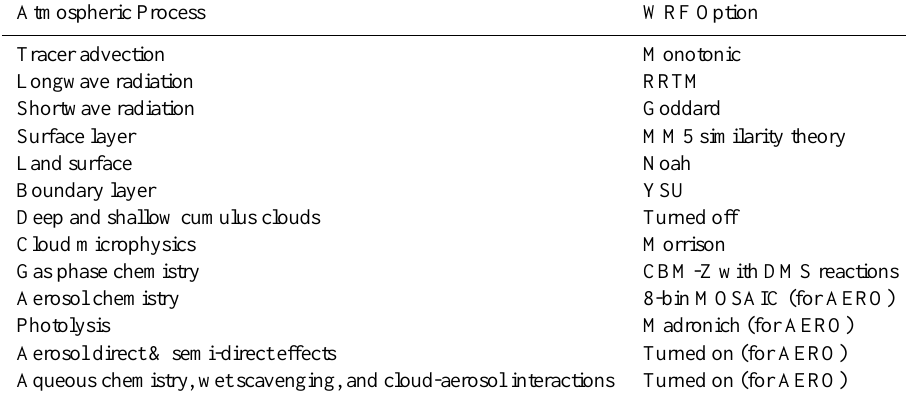
Turned on (for AERO)